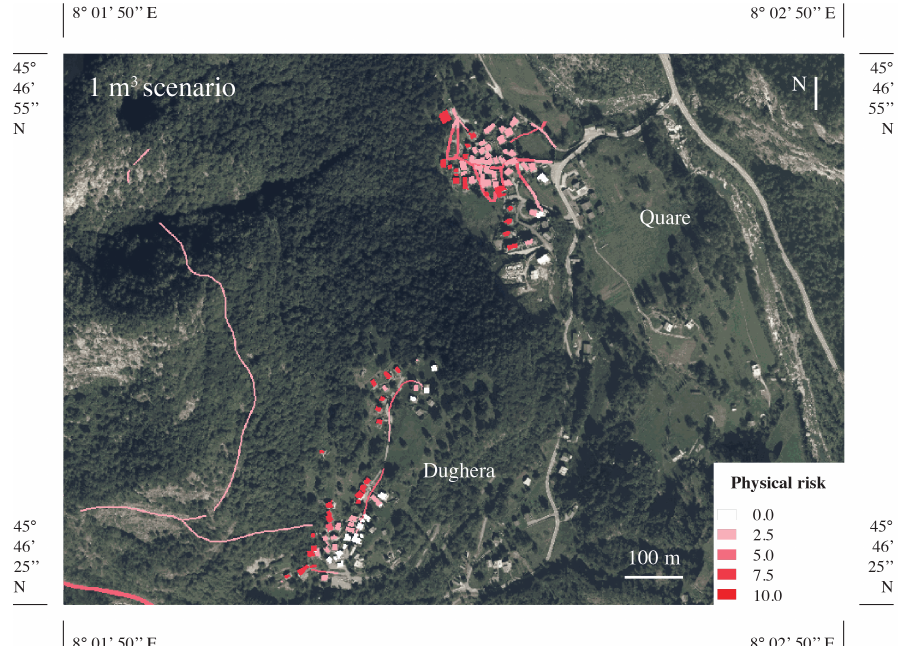
Figure 9. Physical risk map for the hamlets of Dughera and Quare, and the 1 m 3 rockfall scenario.